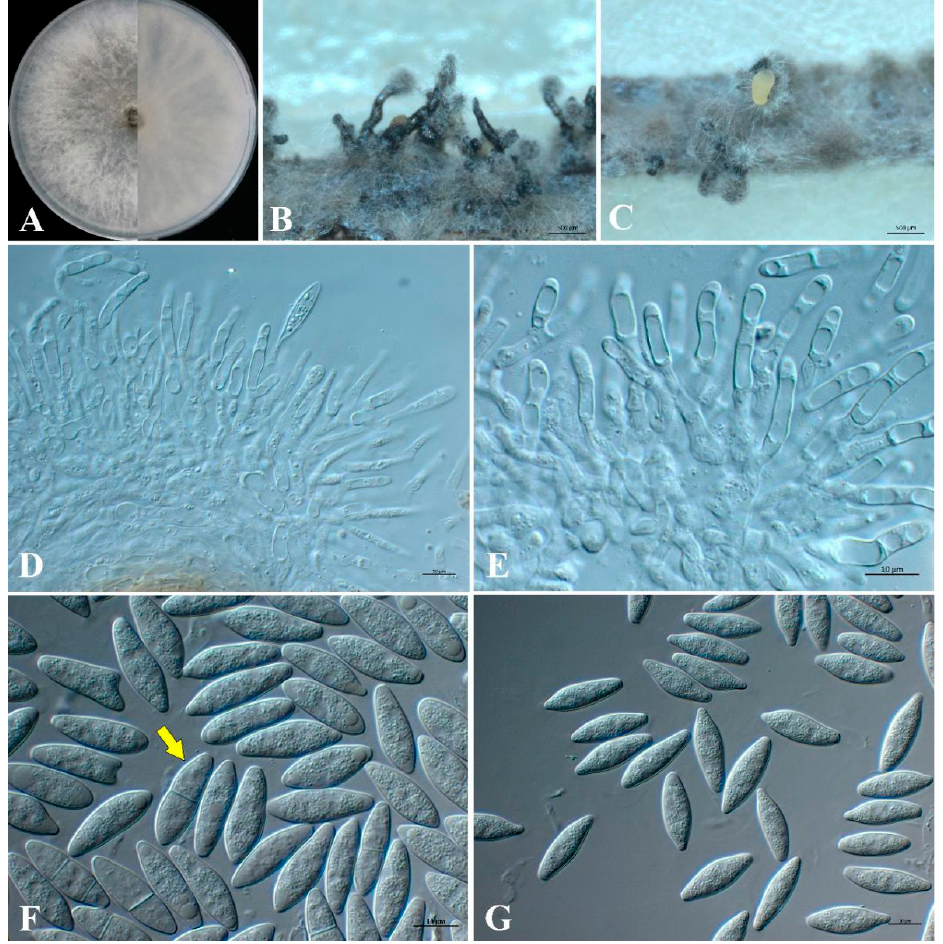
Figure 5. Morphology of Neofusicoccum cryptomeriae (G24). ( A ) Five-day-old front and back view culture on PDA. ( B , C ) Conidioma formed on pine needle culture. ( D ) Conidiophores, conidiogenous cells, and developing conidia. ( E ) Conidiogenous cells. ( F ) Conidia with 1 septum (indicated by arrow). ( G ) Conidia. Scale bars: ( B , C ) = 500 µm; ( D – G ) = 10 µm. Table 2. Synoptic characters of two species of Neofusicoccum in this study and related Neofusicoccum spp.